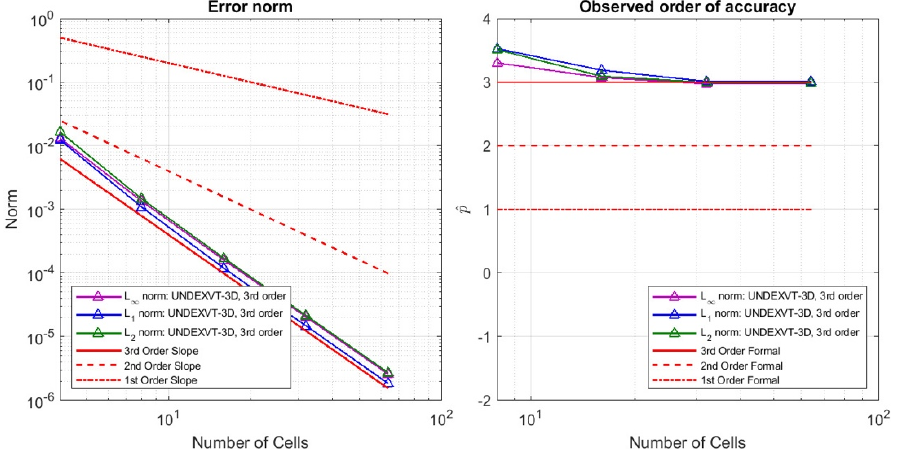
Figure 3. Observed order of accuracy of the 3D third-order solver ( left : error norm; right : observed order of accuracy). Table 3. Observed order of accuracy of 3D third-order solver.